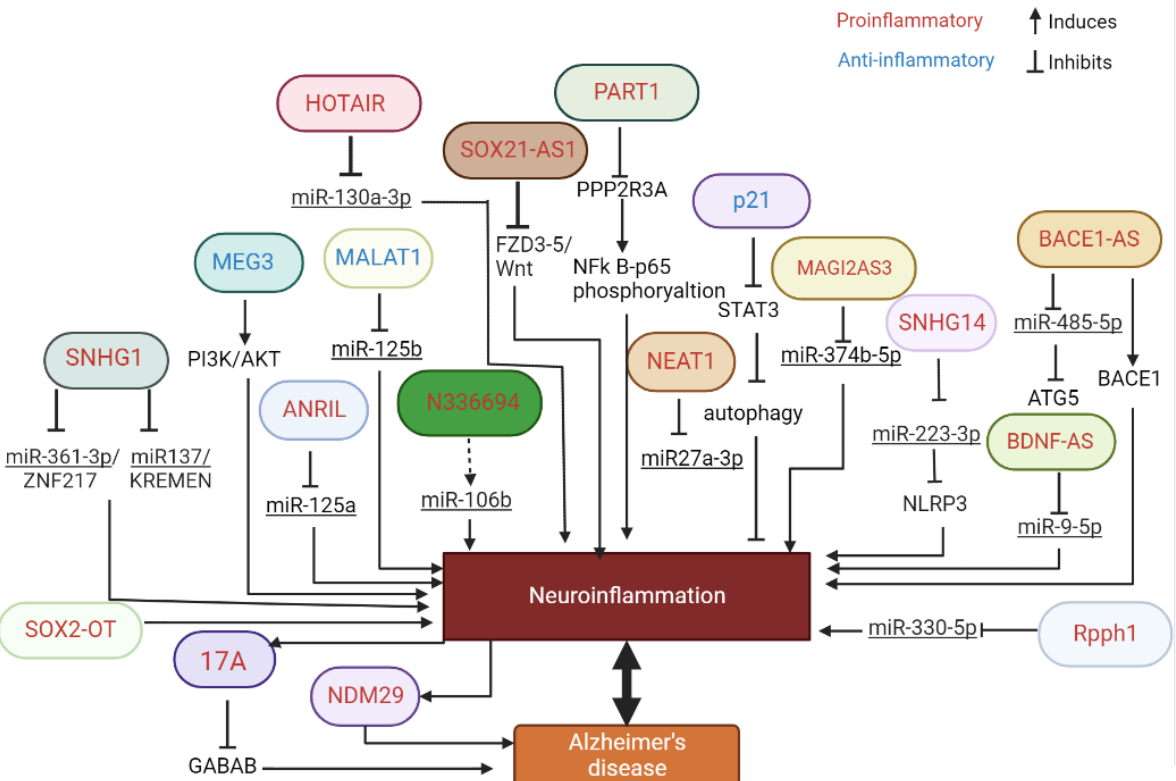
Figure 1. Schematic representation of the multiple pathways regulated by lncRNA involved in inflammation and